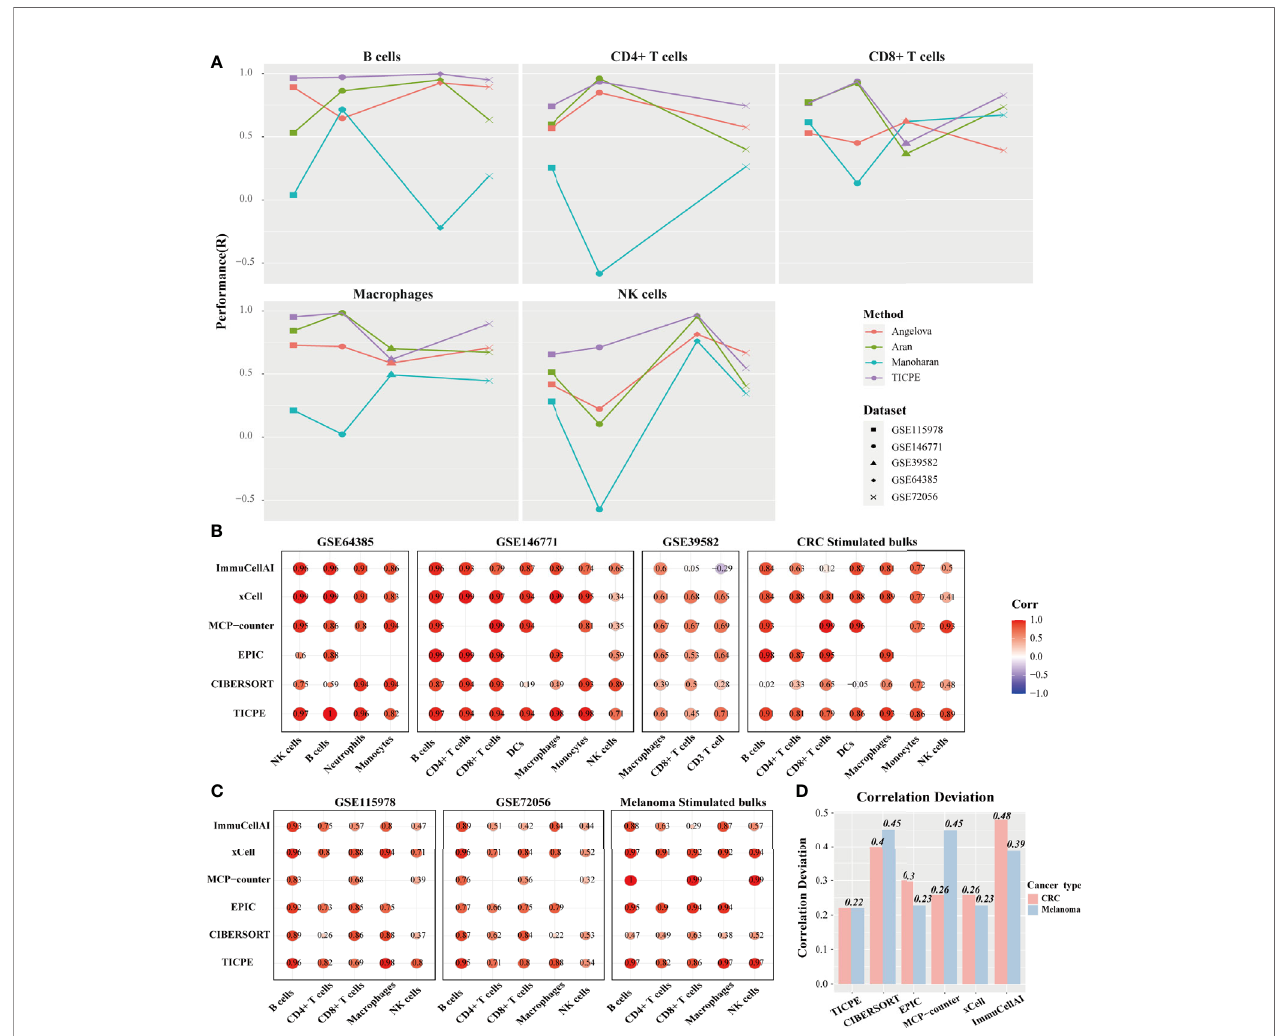
FIGURE 3 | Performance comparison with other methods. (A) Scatter plot organized by cell type showing the performance of different marker gene sets identi fi ed from four sources. Methods performance was quanti fi ed using Pearson ’ s correlation (R). Different colors represented marker genes collated from different methods and different datasets had corresponding shapes. (B, C) Performance of TICPE and other methods on CRC and melanoma validation cohorts, respectively. Here rows corresponded to methods and columns showed the Pearson correlation coef fi cient for the corresponding cell type in each dataset. (D) Correlation deviation of each method in both CRC and melanoma validation